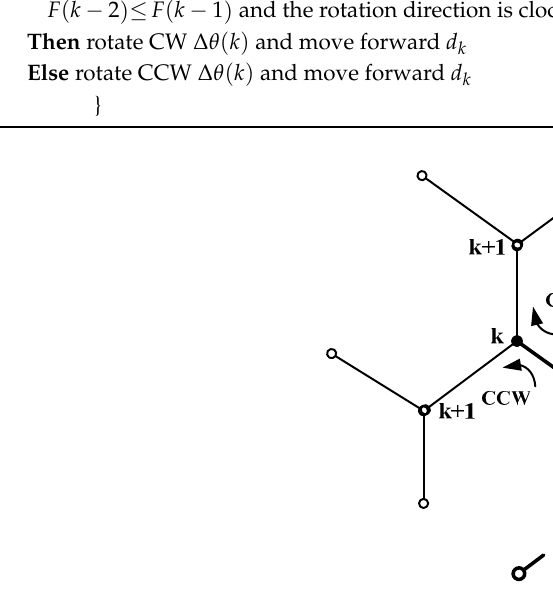
Figure 5. The choice of the turning direction.